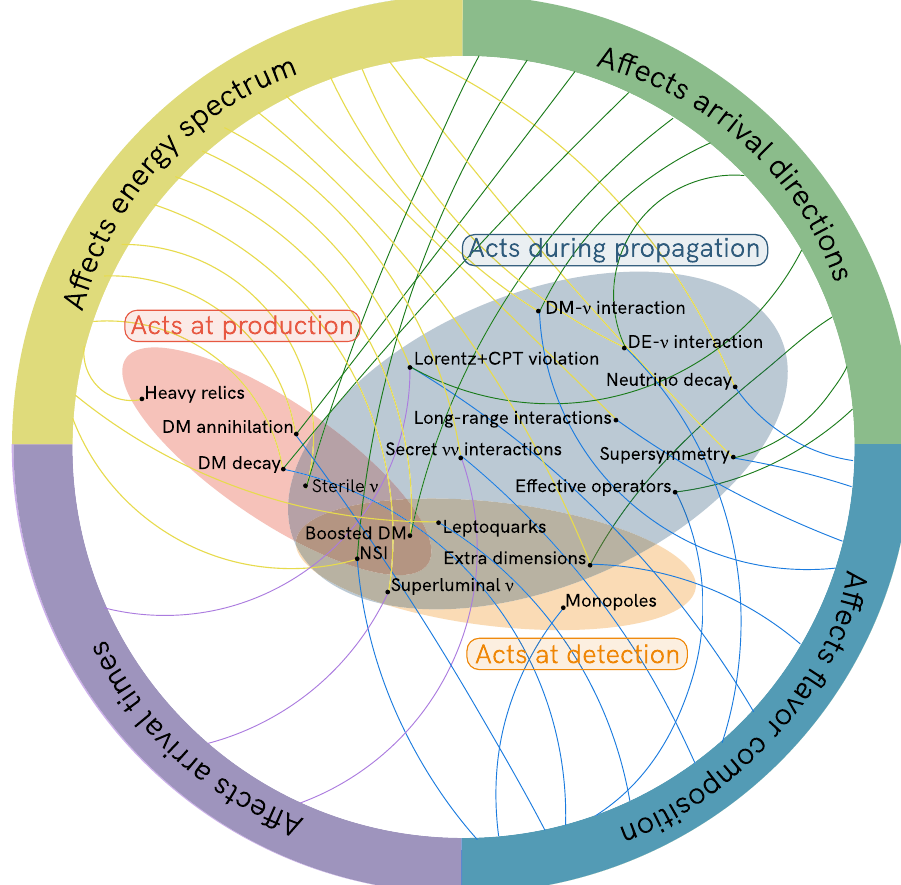
Fig. 15 Models and how they modify high-energy neutrino observables. An incomplete list of models is shown in the center of the figure. When a new physics scenario modifies one of the four observables available in neutrino telescopes (flavor, energy, time, and direction) they are linked by a line from the model to the observable. The location where the new physics happens (production, propagation, and detection) is illustrated by shaded inner regions. Adapted from